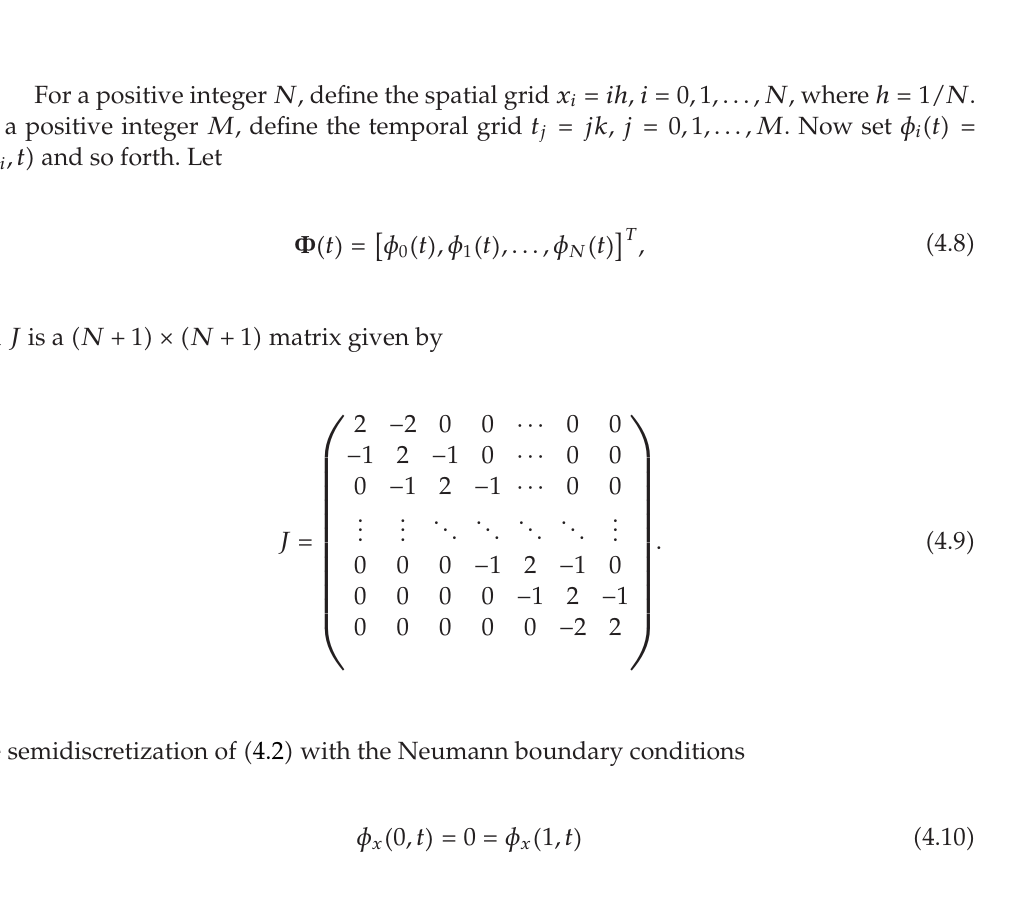
Figure 1: Comparison of the numerical solution by our method (cid:2) LSDFECT (cid:3) , CN method, and exact solution of Problem 1 at di ff erent space points for N (cid:8) 80, ν d (cid:8) 2, and k (cid:8) 0 . 01 at T (cid:8) 0 . 1.